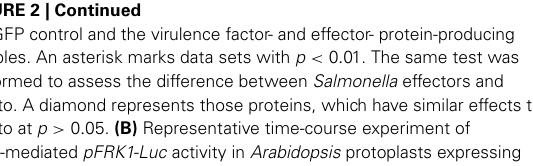
normalized to the expression of the house-keeping gene actin . The graphs show one representative experiment out of three. Data is presented as mean values ± s.e.m. of three technical replicates. Expression of FRK1 , WRKY17, and Sec61 was attenuated in protoplasts in the presence of SpvC. However, SpvC had no impact on the expression of 4CL